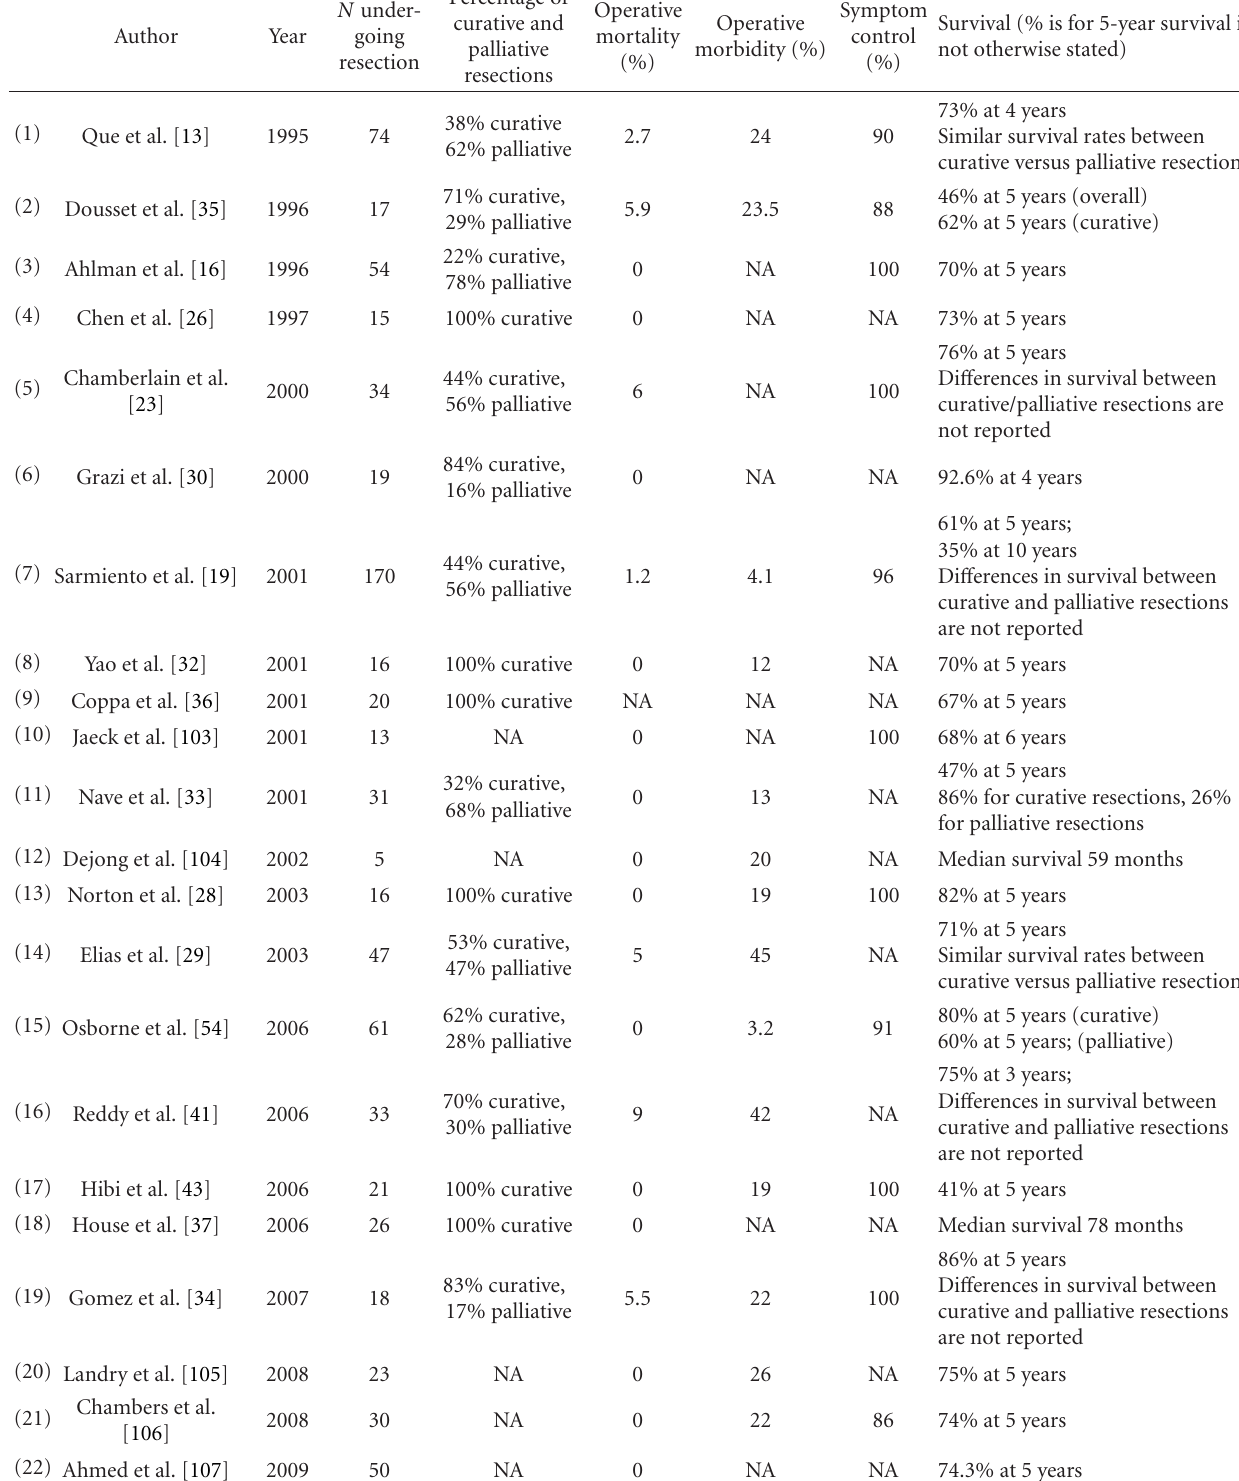
Table 1: Case series of hepatic resections performed for neuroendocrine liver metastases published in the past 15 years. The following table summarizes the results of modern-day series of liver resections performed for neuroendocrine tumors liver